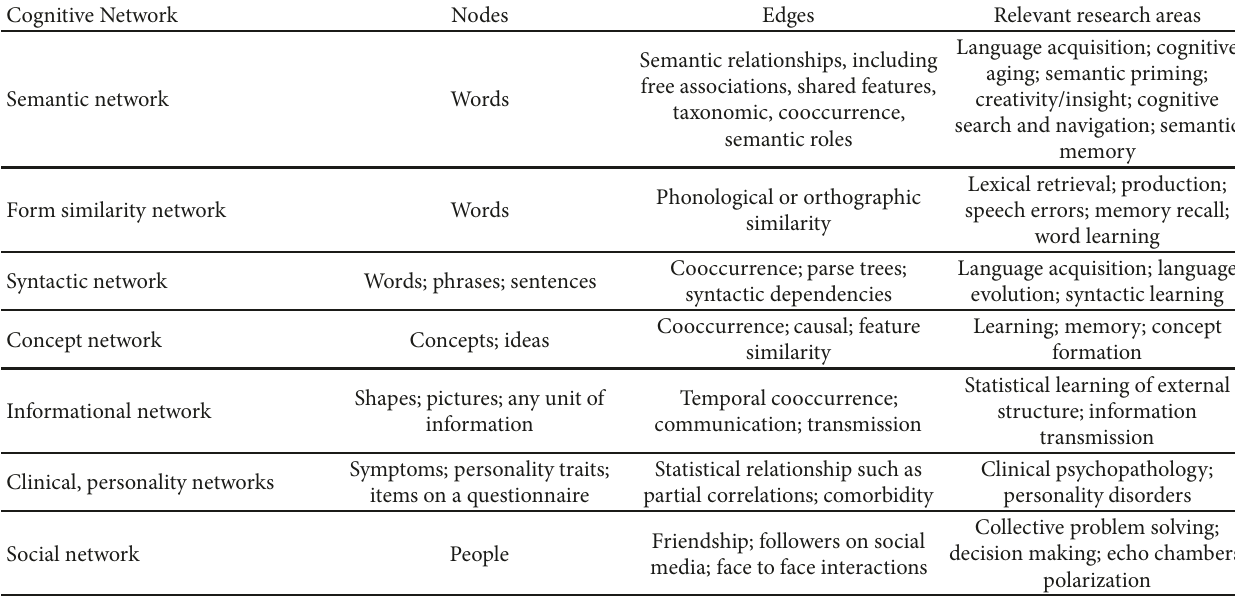
Table 1: Examples of cognitive networks and their cognitive